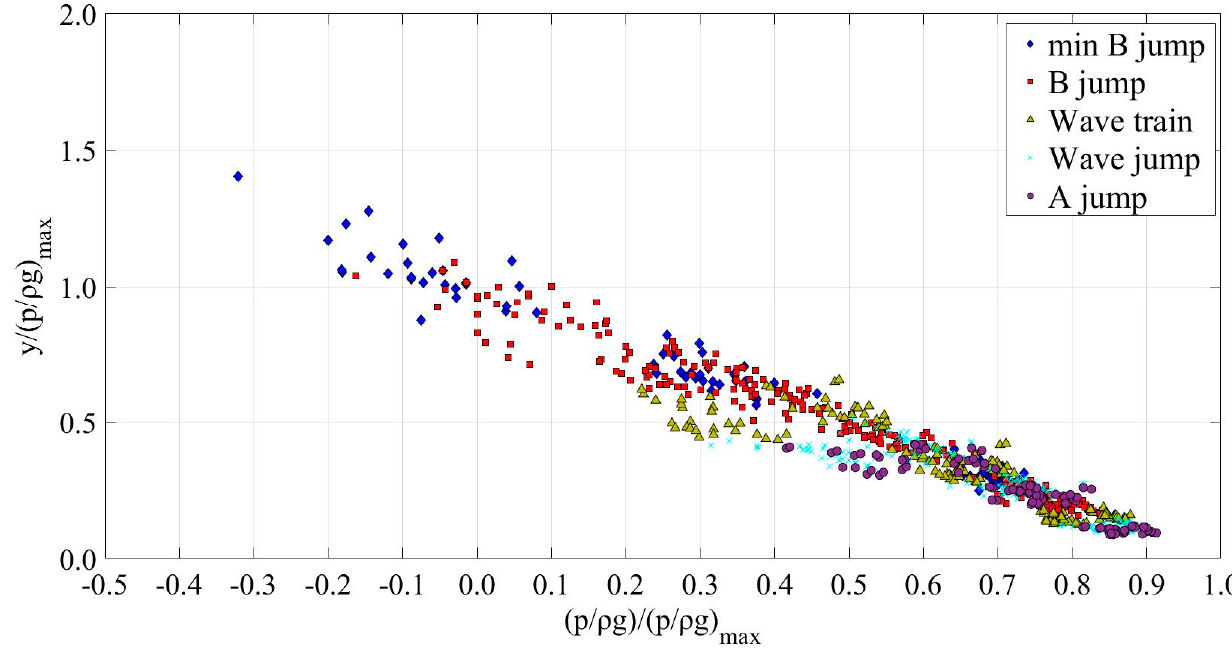
Figure 9. Dimensionless pressure head (p/ ρ g)/(p/ ρ g) max at the face of the step versus dimensionless vertical distance from bottom y/(p/ ρ g) max for all types of flow.